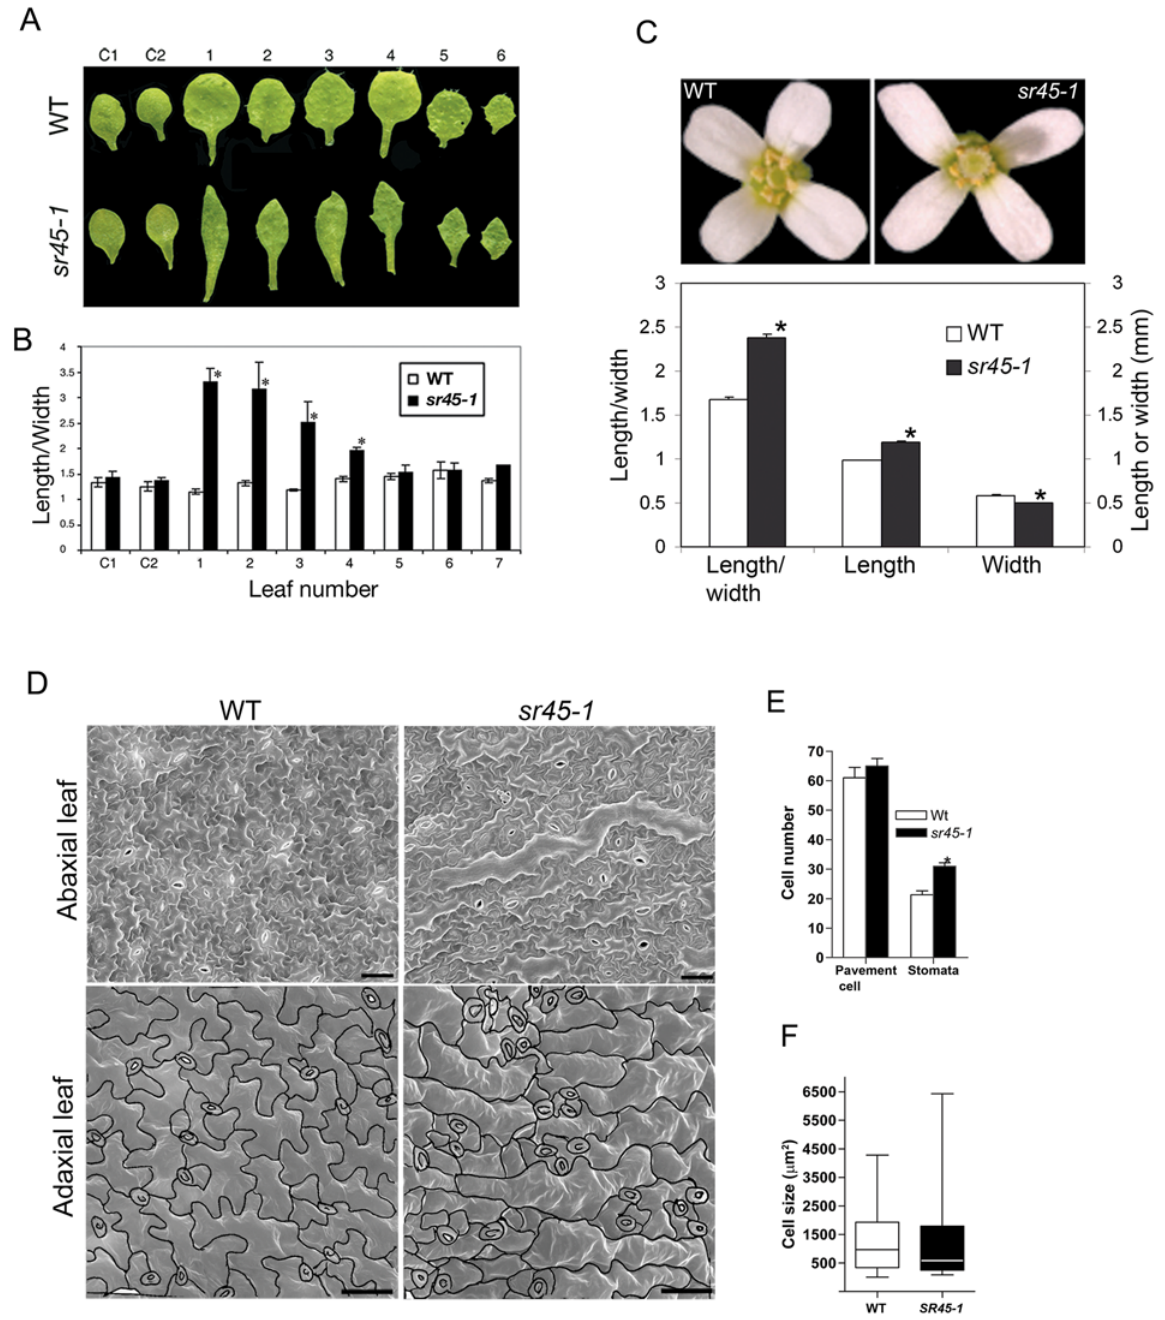
Figure 6. sr45-1plants have elongated leaves and petals. (A) WT and sr45-1 plants grown on MS plates. Note that sr45-1 has elongated leaves. Cotyledonary leaves (C1 and C2) and true leaves are numbered from left (older) to right (younger). (B) Leaf length/width ratios (Mean 6 SEM) of WT and sr45-1 plants. ( n =11 leaves from 11 plants, Student’s t -test p -values are as follows: Cotyledon (C1), p =0.52; Cotyledon (C2), p =0.39; leaf 1, p =0.002; leaf 2, p =0.021; leaf 3, p =0.022; leaf 4, p =0.0003; leaf 5, p =0.33; leaf 6, p =0.49; leaf 7, p =0.29). The symbol ‘*’ on the top of bars indicate that the difference between WT and sr45-1 is significant ( p , 0.05). (C) Fully opened flowers of sr45-1 plants have elongated petals. The bottom panel shows quantification of length, width and length/width ratio (Mean 6 SEM) of petals in WT (WT) and mutant ( sr45-1 ) plants ( n =16, Student’s t -test p - values: length, p =10 2 9 , width, p =10 2 8 ; length/width p =10 2 10 ). The symbol ‘*’ on the top of bars indicate that the difference between WT and sr45-1 is significant ( p , 0.05). (D) The leaves of sr45-1 plants exhibit abnormal expansion of pavement cells. Scanning electron micrographs of the abaxial and adaxial surfaces of WT and sr45-1 plants. Note the presence of abnormal elongated abaxial pavement cells in sr45-1 . For clarity, the boundaries of pavement cells on the adaxial surfaces are outlined. Note the presence of markedly enlarged and elongated pavement cells in sr45-1 leaves. Bars=50 m m. (E) Quantitative analyses of the number of pavement cells and stomata in WT and sr45-1 . Each bar is the average 6 SEM of cells counted in at least three 160 mm 2 areas in three different leaves. The p -values of the t -test statistics of pavement cell and stomata were 0.55 (non-significant) and 0.03 (significant, indicated by ‘*’), respectively. (F) Box plots of the distribution of cell sizes in WT and sr45-1 pavement cells. Each box plot was made from the cell sizes of WT ( n =112) and sr45-1 ( n =128) from at least three different leaves. Boxes indicate the interquartile range between the 1st and 3rd quartile, whereas line in the middle of the box represents median. Ends of the vertical lines indicate the range of the data.